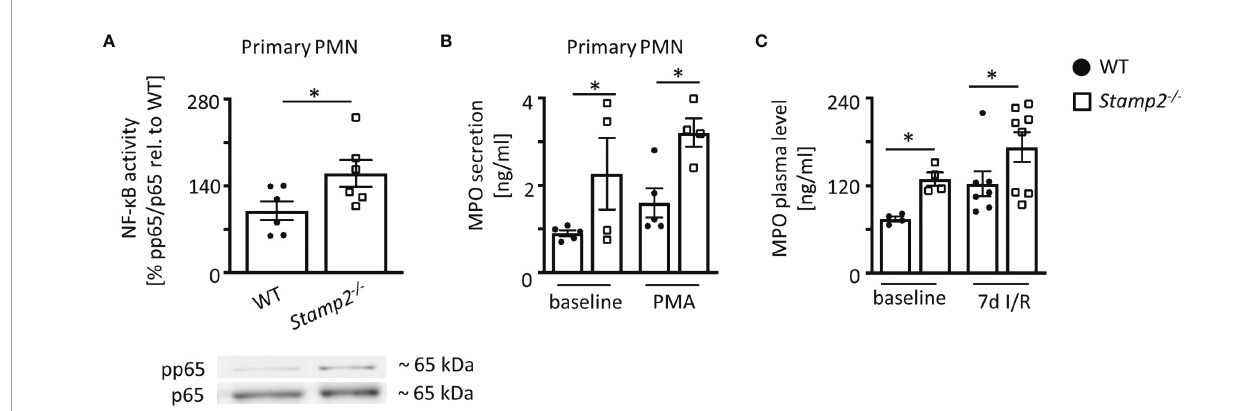
FIGURE 4 | Proin fl ammmatory activation of PMN by Stamp2 de fi ciency. (A) Immmunoblotting of p65-phosphorylation (pp65) vs. total p65 expresssion as an indicator of NF- k B activity (n=6/6). (B) Myeloperoxidase (MPO) secretion into the supernatant of isolated PMN as assessed by ELISA with and without in fl ammatory stimulation (PMA 100ng/ml; n=5/4/5/4). (C) MPO plasma levels in mice at baseline and subjected to 7 days of I/R as assessed by ELISA (n=4/4/7/8). Graphs show Mean ± SEM. Full blots are shown in Supplemental Figure S5 . Signi fi cance was determined by two-way ANOVA followed by Tukey post-hoc test (B, C) or by unpaired Student ’ s t-test (A) . *P <